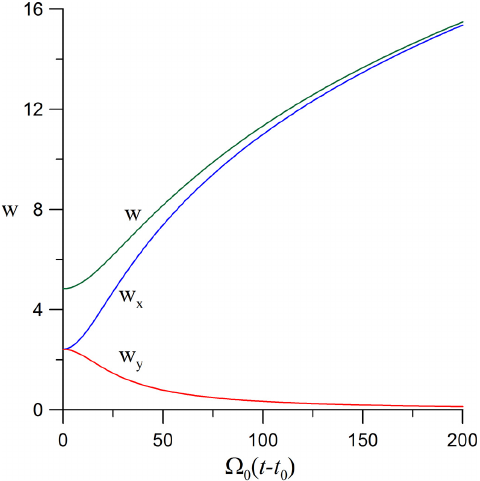
Fig. 3. Temporal evolution of E y far from the source, (x 0 − x)/l = 0 . 1.